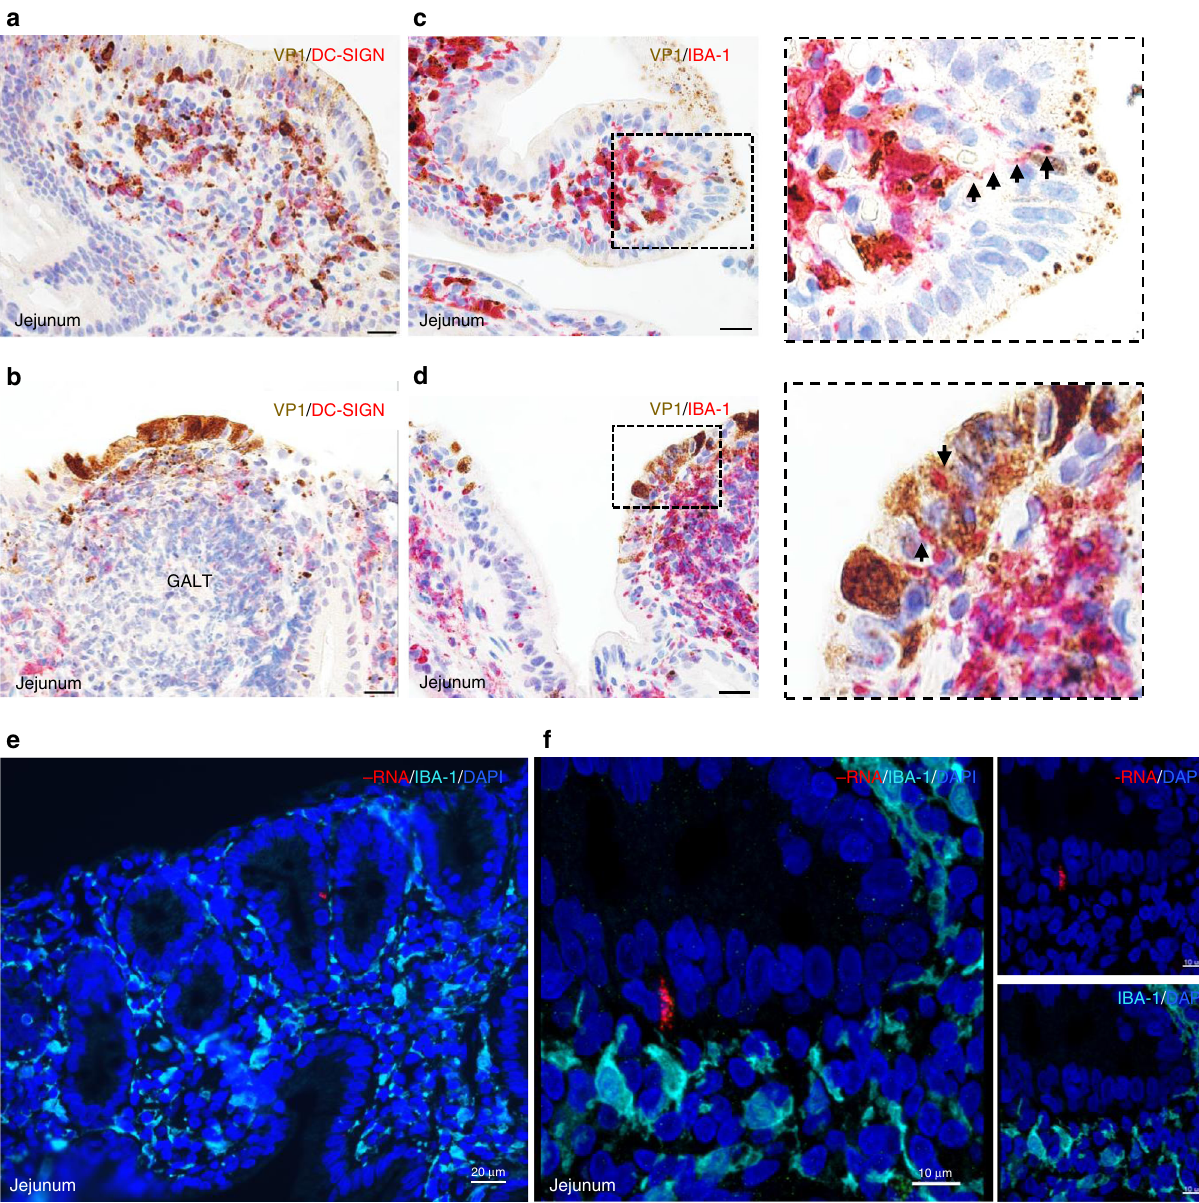
Fig. 5 Association of norovirus VP1 capsid protein with myeloid immune cells in the lamina propria. Chromogenic staining and bright fi eld imaging were used to show the relationship between VP1 and DC-SIGN bearing cells in two areas of the GT-1 small intestine. a Villus structure showing VP1 and DC- SIGN staining merged, with heavy presence of VP1 within the LP. b Area containing GALT showing VP1 and DC-SIGN staining merged. c View near villus tip shows association of VP1 with macrophage bearing IBA-1 in the LP. Magni fi ed inset shows extension of a macrophage dendrite appearing to engulf VP1 antigen (marked by arrows). d An area of intense VP1 expression in the epithelial layer is shown with an accumulation of underlying macrophage containing aggregated VP1. Magni fi ed inset highlights evidence for direct interaction of IBA-1 positive cells with the epithelium as indicated by